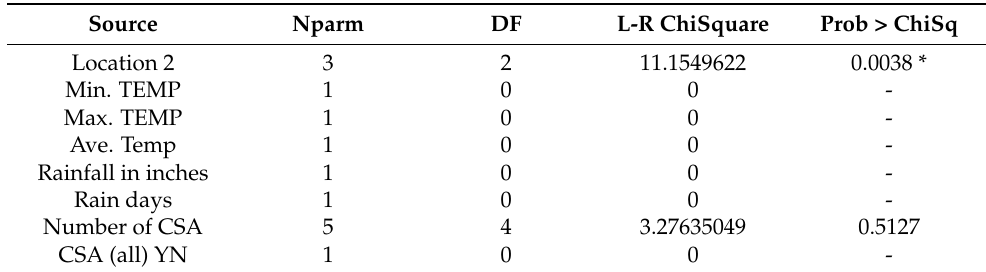
Table 3. Effect likelihood ratio test (ELRT) carried out to determine which factors influence the HFIAS scores of households across all four CSVs.